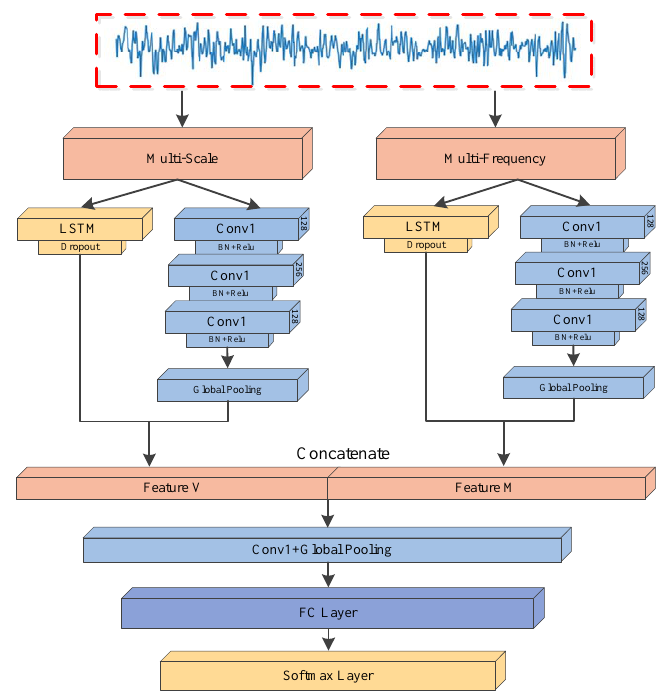
Figure 2. The proposed multiscale convolutional and recurrent neural network (MCRNN)